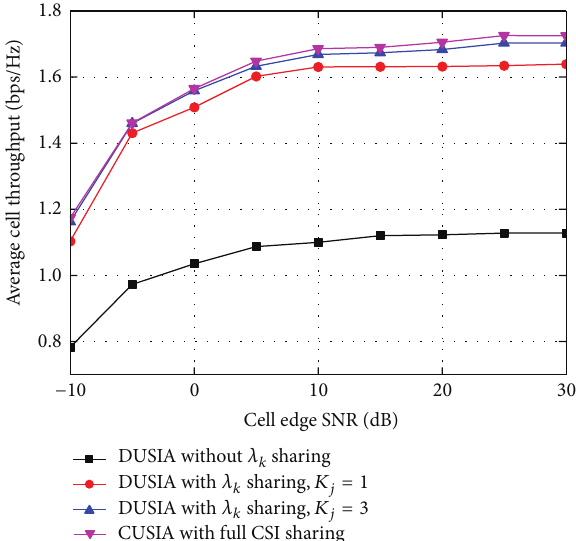
Figure 4: Average cell throughput comparison of BD-CUS, INUS, and DUSIA. 𝜉 = 1 , 10 users per cell.